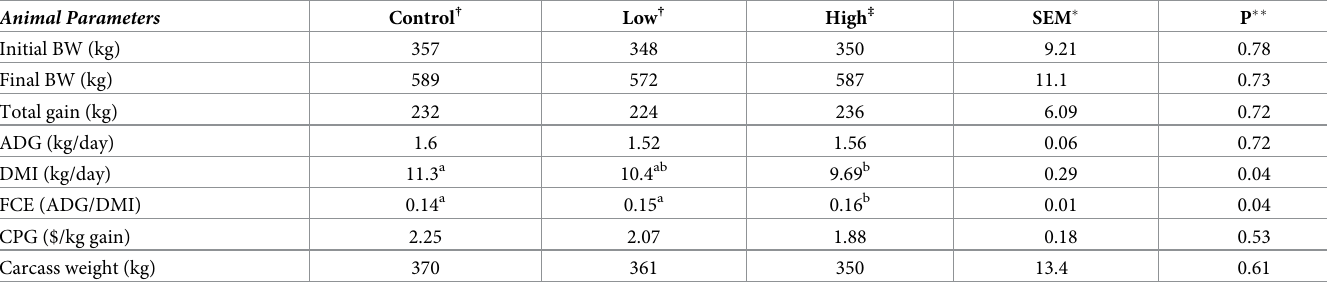
Table 4. Effect of Asparagopsis taxiformis inclusion at 0.25% (Low), and 0.5% (High) feed organic matter on beef animal parameters over 21 weeks. Animal Parameters